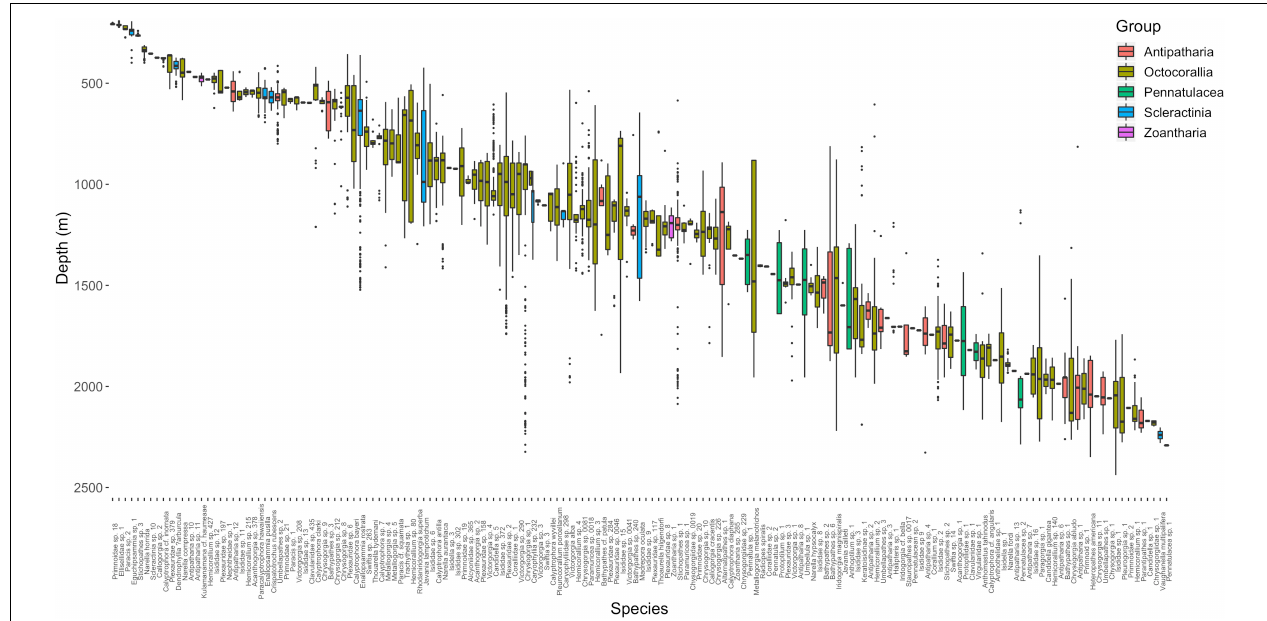
FIGURE 2 | Depth distribution of 167 morphospecies observed from video analyses within PIPA. Boxes are colored according to taxonomic groupings and are arranged by increasing median depth of occurrence. TABLE 2 | Water masses and environmental characteristics observed in the Phoenix Islands Protected Area during cruises FK171005 and EX1703. Water mass Temperature ( ◦ C) Salinity (psu) Dissolved oxygen Pacific Equatorial Water (PEW)